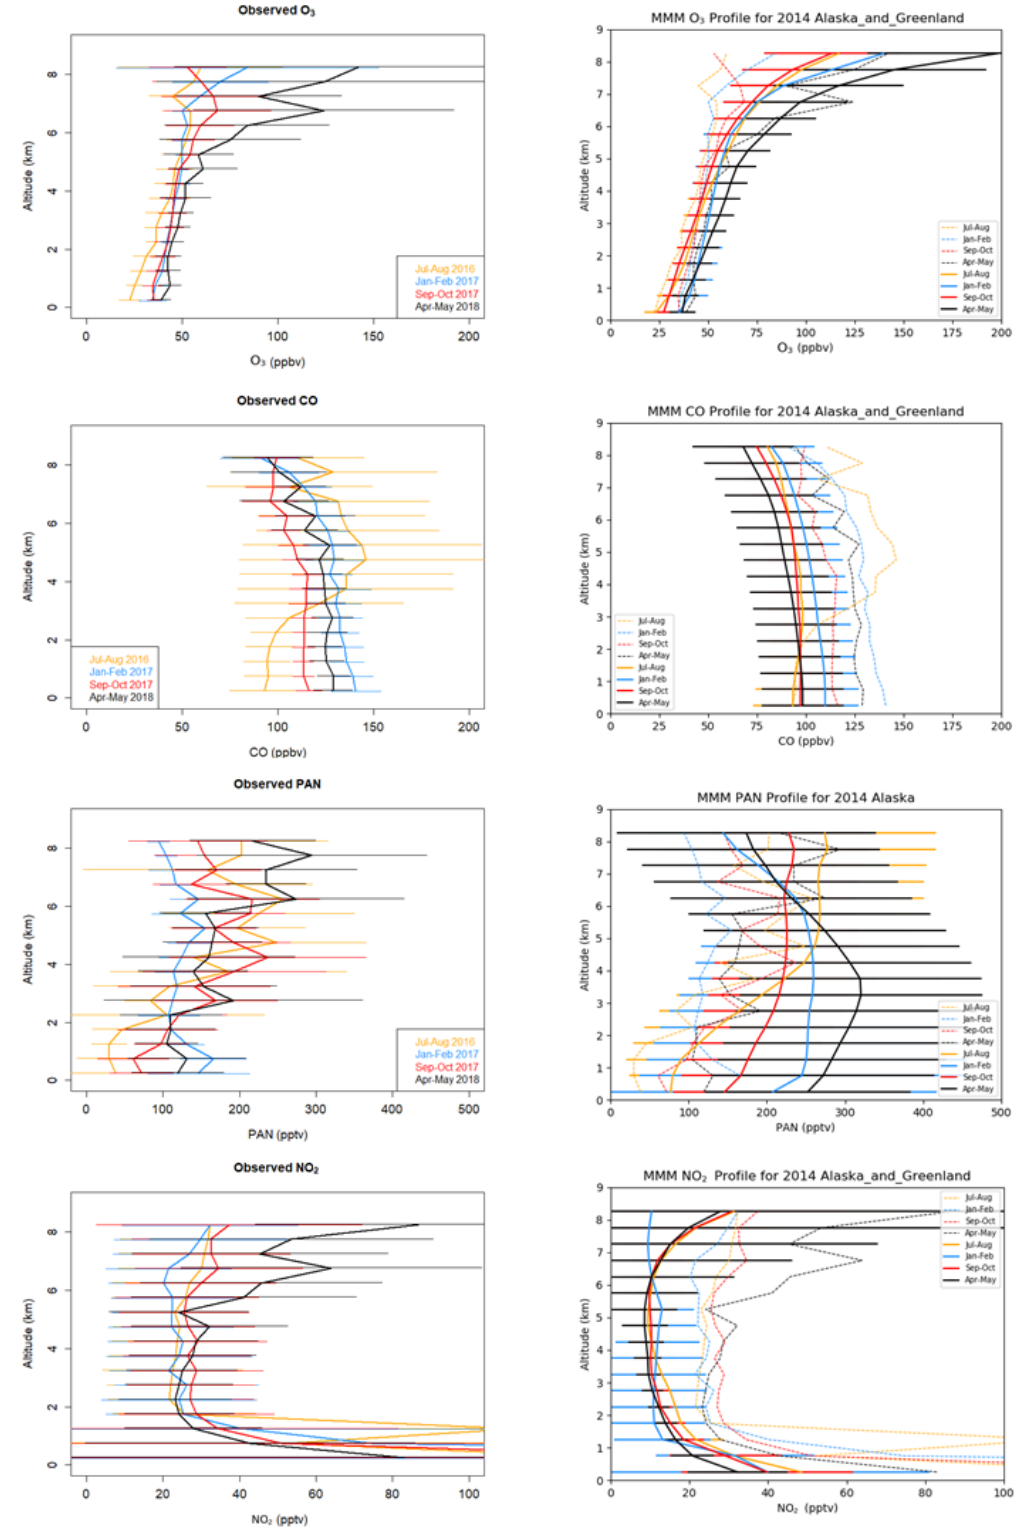
Figure 9. Mean vertical profiles of O 3 , CO, PAN, and NO 2 (left) measured in Alaska and Greenland from the NASA ATom missions during summer 2016, winter 2017, autumn 2017, and spring 2018 (horizontal lines indicate 1 standard deviation spread around mean values at each altitude). The (right) MMM for the years 2014–2015 (with the MMM standard deviation as horizontal lines). The observations appear as dashed lines in the right panels for ease of comparing to the